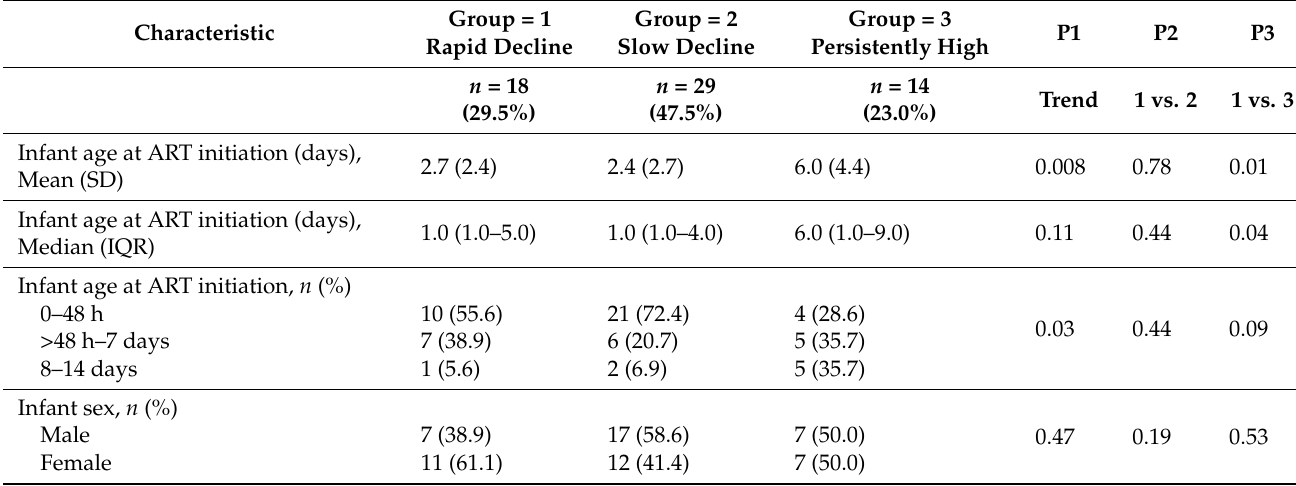
Table 4. Factors associated with viral response through 72 weeks following trajectory membership groups determined by latent class growth